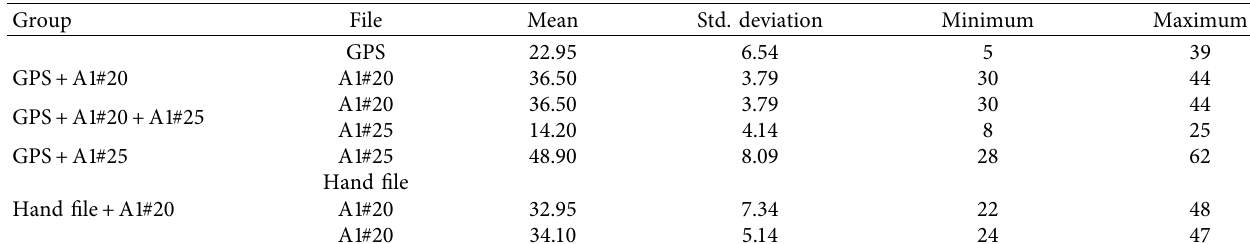
Table 4: Number of peckings (GPS is in a single row because it was used in different groups).